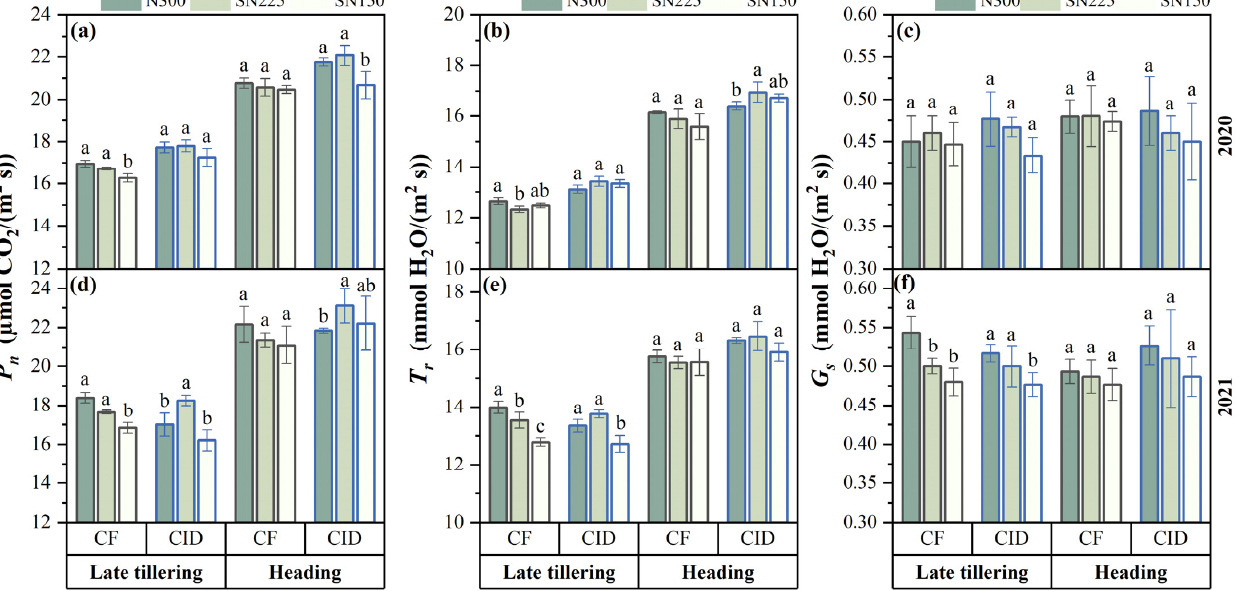
Figure 5. Dynamics of photosynthesis rate ( P n ), stomatal conductance ( G s ) and transpiration rate ( T r ) at late tillering and heading stages of rice for various water and fertilizer treatment combinations in 2020 ( a – c ) and 2021 ( d – f ) seasons. CF and CID denote continuously flooded and controlled irrigation and drainage, respectively. N300 denotes conventional farmers’ fertilization of 300 kg N ha − 1 without straw addition, while SN225 and SN150 denote straw return with 225 and 150 kg N ha − 1 fertilizer, respectively. Different letters indicate significant differences at p < 0.05.